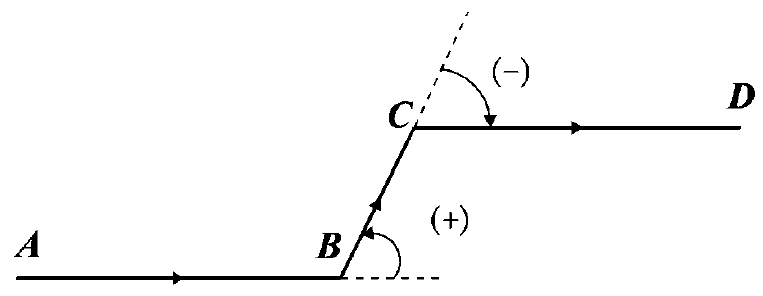
Figure 5. Schematic map of the size and direction of the intersection angle. Table 1. Graphical units, identification methods and LoD parameters of artificial building polygons.